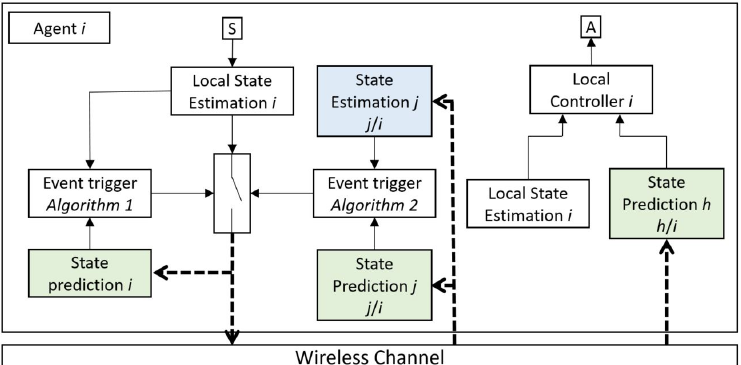
Figure 2. Event triggering algorithm is based on DEBSE for each agent i = 1, . . . , N in a multi- agent system. The dynamics of each physical plant are connected to its agent via sensors (S) and actuators